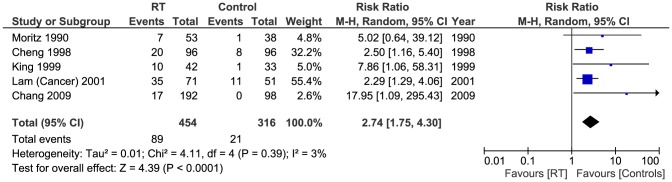
Forest plot: Low grade stenosis.